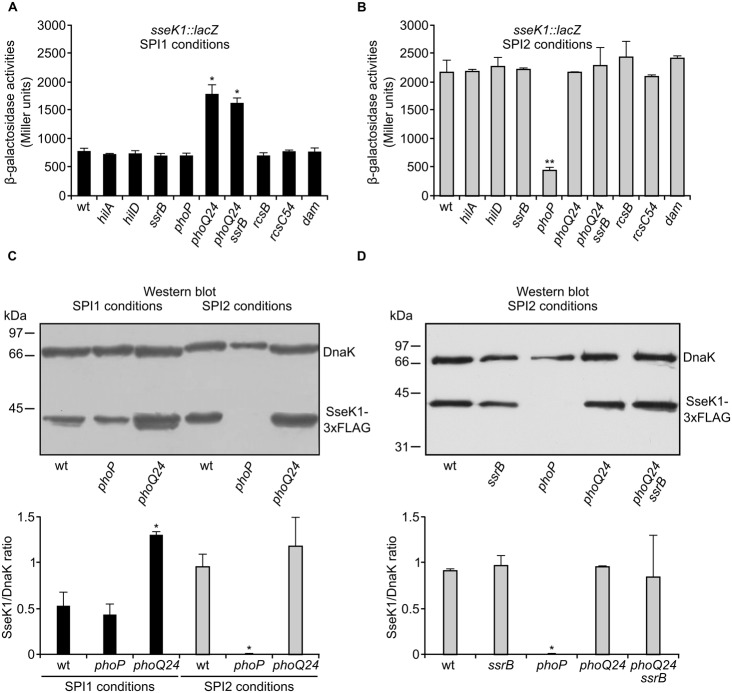
Positive regulation of the expression of sseK1 by the PhoQ/PhoP system. β-Galactosidase activities were measured from SPI1-inducing (A) and SPI2-inducing (B) cultures of several S. enterica serovar Typhimurium strains: wild-type 14028 (wt), null mutants (hilA, hilD, ssrB, rcsB, and dam), and mutants with constitutive activation of the PhoQ/PhoP system and the Rcs system, respectively (phoQ24 and rcsC54), carrying an sseK1::lacZ translational fusion. The role of SsrB in the regulation by PhoP was investigated in a double mutant phoQ24 ssrB. Means and SD from three independent β-galactosidase measurements are shown. The effect of the PhoQ/PhoP system (C) and of SsrB (D) on sseK1 expression at the protein level was assessed by immunoblot analysis using strains expressing SseK1-3xFLAG. A monoclonal anti-FLAG antibody was used to detect the fusion protein and a polyclonal anti-DnaK antibody was used to get a loading control. Representative gels are shown together with quantification of bands (SseK1/DnaK ratio) from duplicate gels. Statistical significance of the differences between wt and mutant strains is shown by asterisks representing t-test P values: ∗P < 0.05; ∗∗P < 0.01.